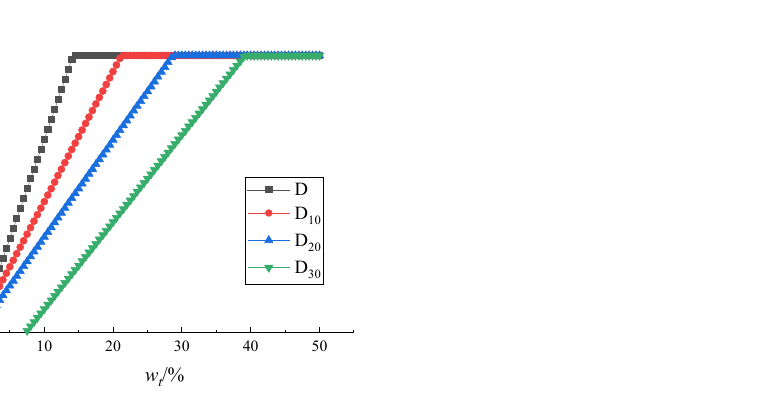
Figure 8. The damage variance curve of water-containing sandstone under different stress paths.